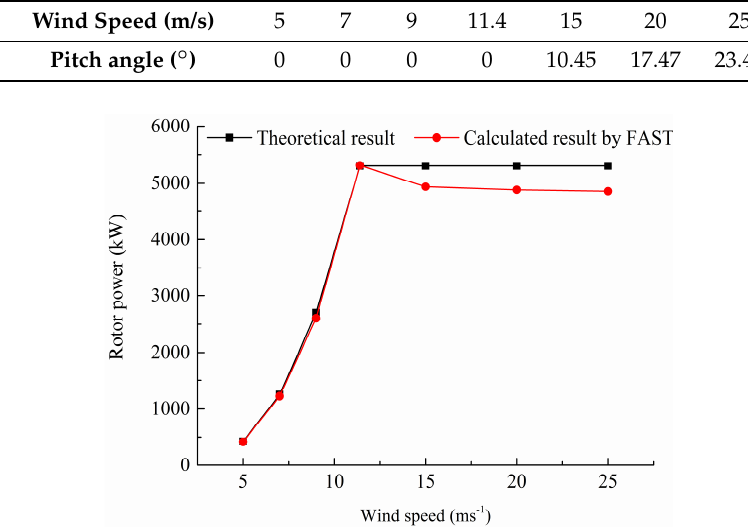
Table 4. Blade pitch angles at different wind speeds.